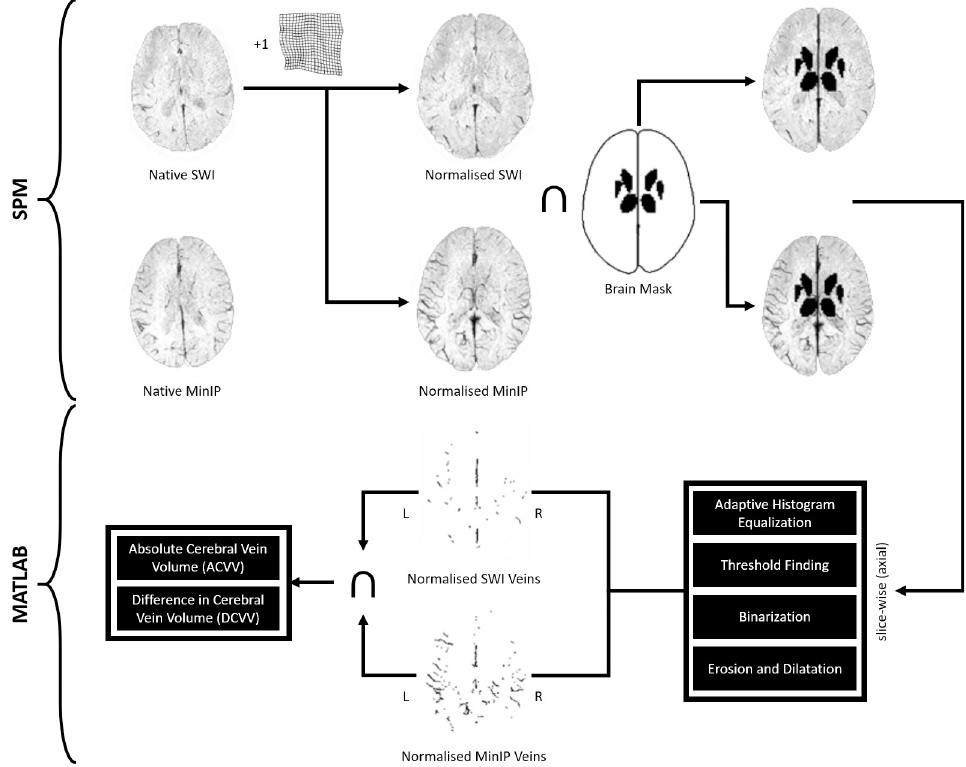
Fig 2. Processing pipeline of automated quantification of cortical and subcortical veins.